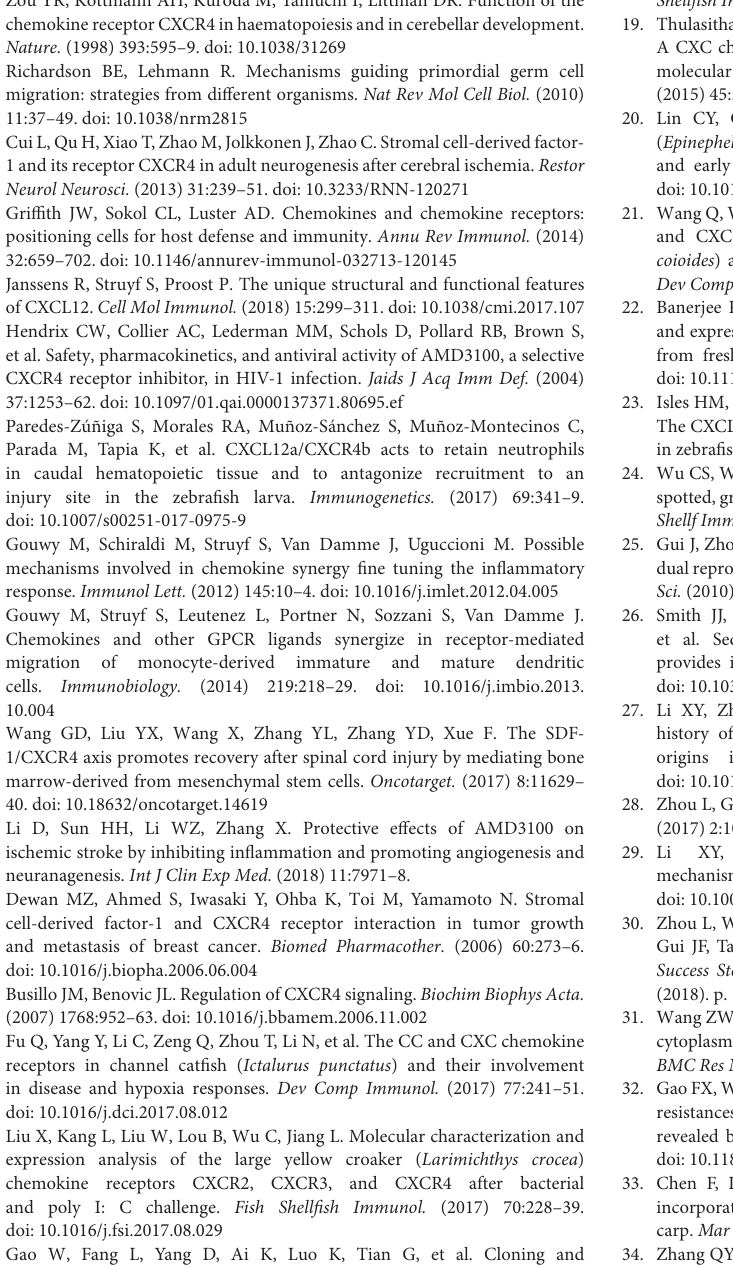
Supplementary Table 1 | Primers used in this